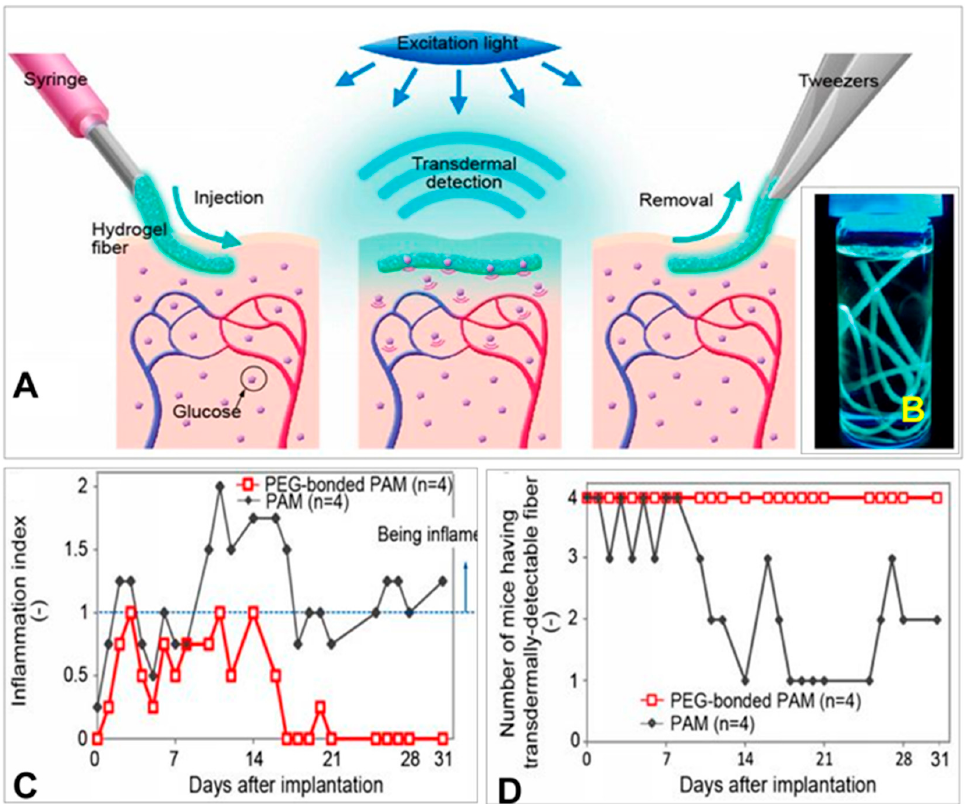
Figure 22. ( A ) Schematic illustration of the fluorescent hydrogel fiber designed for long-term in vivo glucose monitoring. The fiber can be injected into subcutaneous tissues. The implanted fiber remains at the implantation site for a long period and transmits fluorescent signals transdermally depending on blood glucose concentration. The implanted fiber can be easily removed from the implantation site after use. ( B ) Fluorescent hydrogel fibers in a glass vial with a 50% glucose solution. The fibers are excited by ultraviolet light. The fluorescent image indicates that the glucose-responsive monomer is immobilized within the hydrogel fibers. ( C ) Inflammation indices of the mouse ears with the fibers one month after implantation. Inflammation was evaluated based on reddening, swelling and scab formation for a month. The inflammation index was obtained by summing the reddening, swelling, and scab formation scores. If the ear skin showed any reddening, reddening scores 1 point; similarly, swelling and scab formation were each also scored 1 point. PEG-bonded PAM induced less inflammation than PAM only. ( D ) Numbers of mice showing transdermal transmission of fiber fluorescence [67].